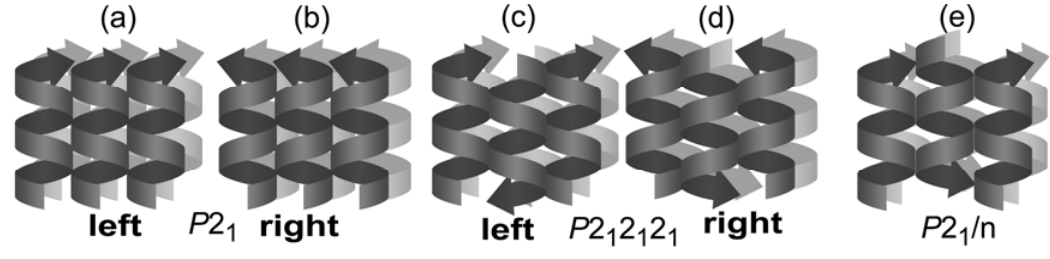
Figure 14. Bundles of helices with three-axial, tilt, and helical chirality. Stacking in an identical direction with left-handed helices (a) and right-handed helices (b), in the reversed direction with left-handed helices (c) and right-handed helices (d), with both left- and right-handed helices